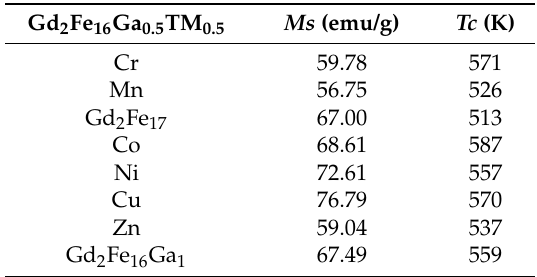
Table 4. Room temperature saturation magnetization, Ms , and Curie temperature, Tc , of Gd 2 Fe 17